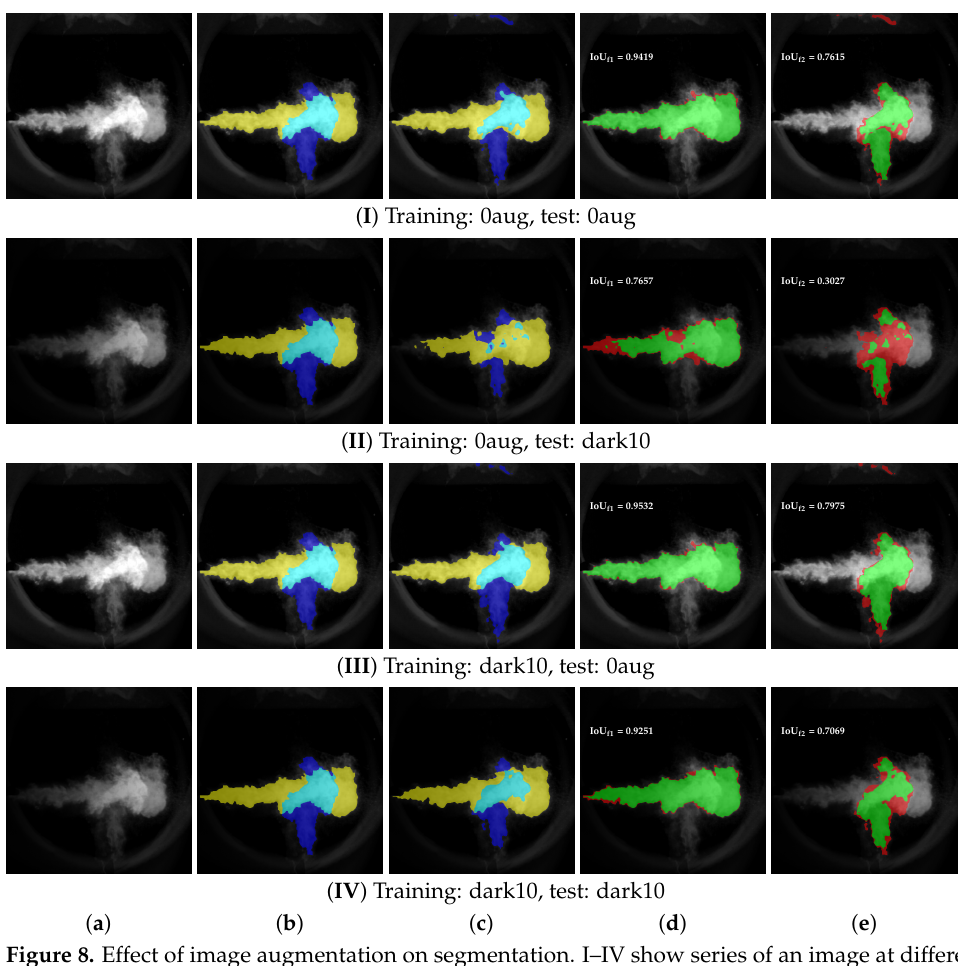
Figure 8. Effect of image augmentation on segmentation. I–IV show series of an image at different conditions of training or test data darkening augmentation as specified underneath each series. In every series image, subfigure ( a ) shows an original image example in our test data set. ( b ) The corresponding ground truth and ( c ) segmentation inference with a CNN. ( d , e ) Visualizations of the differences between the ground truth and the prediction of flame 1 ( d ) and flame 2 ( e ). The green mark-up indicates matching pixels between ground truth and prediction, whereas red mark-up indicates mismatched